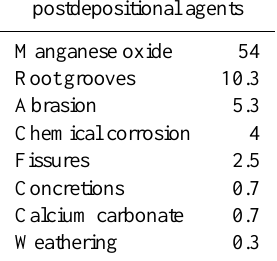
Table 3. Percentage representations of alterations caused by post- depositional agents in Canyars